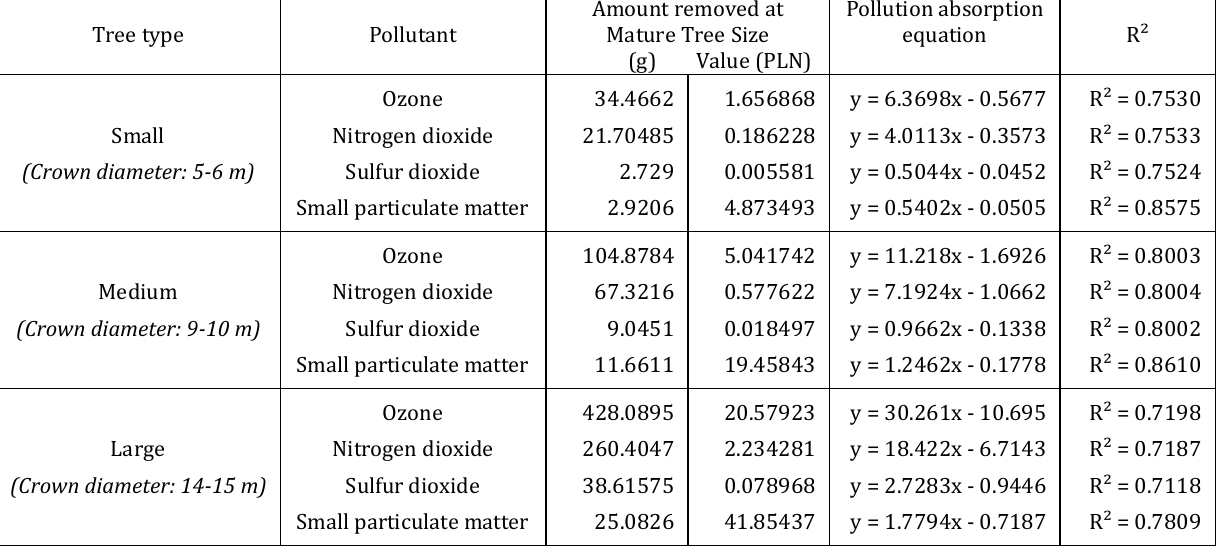
Table 4. Annual benefits at Mature Tree Size for representative small ( Plum ), medium ( Black locust ) and large ( Little leaf linden ) trees (source: author’s own elaboration based on the results of the i-Tree Eco